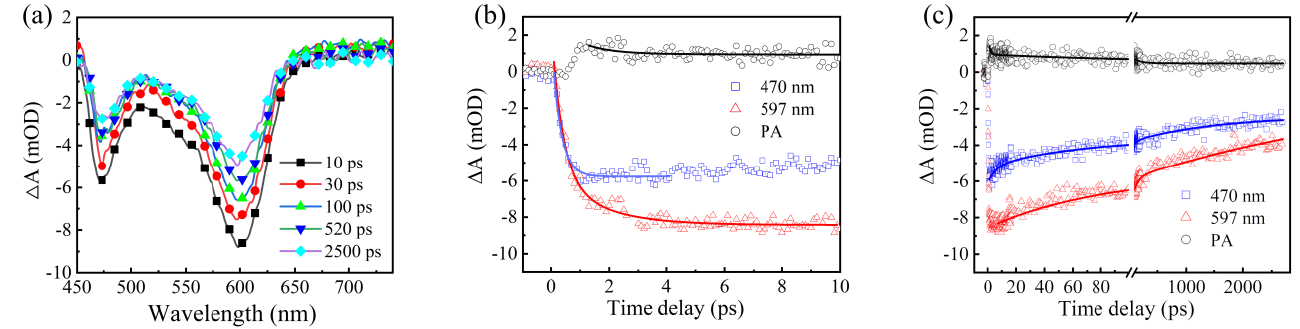
Figure 4. ( a ) TA spectra of the CSS − QDs pumped at 400 nm. The formation process ( b ) and decay dynamics ( c ) at 597 nm, 470 nm and PA extracted from ( a ). The solid lines are fit curves. constants of the 597 nm signal are 76 ± 5 ps ( τ css